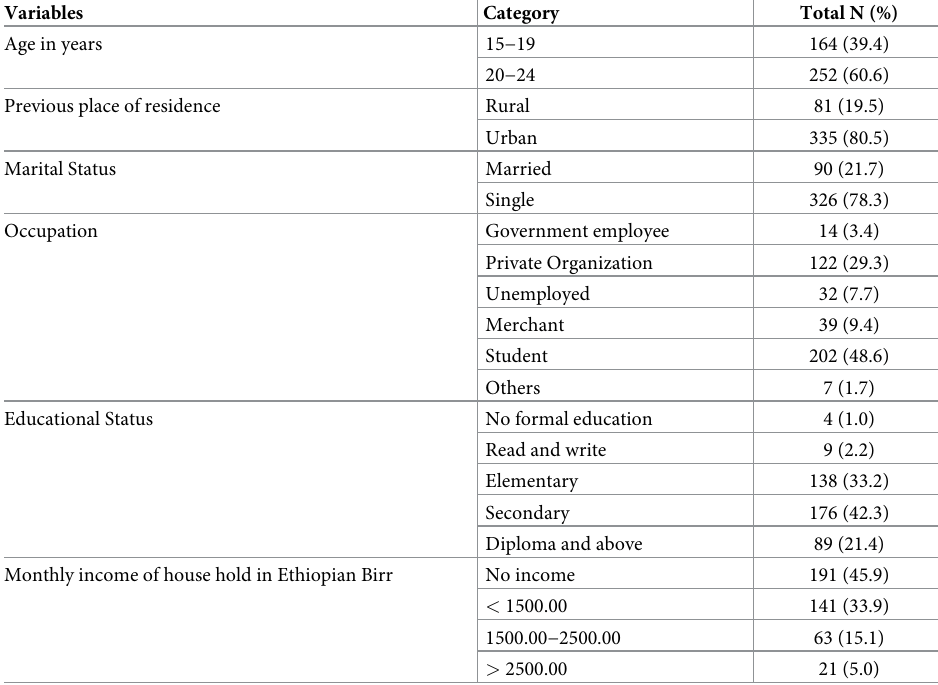
Table 1. Socio-demographic characteristics of youth-friendly services Attendees at selected health facilities in Hawassa city, Sidama Regional State, Ethiopia, May 1 to August 30, 2021 (N =